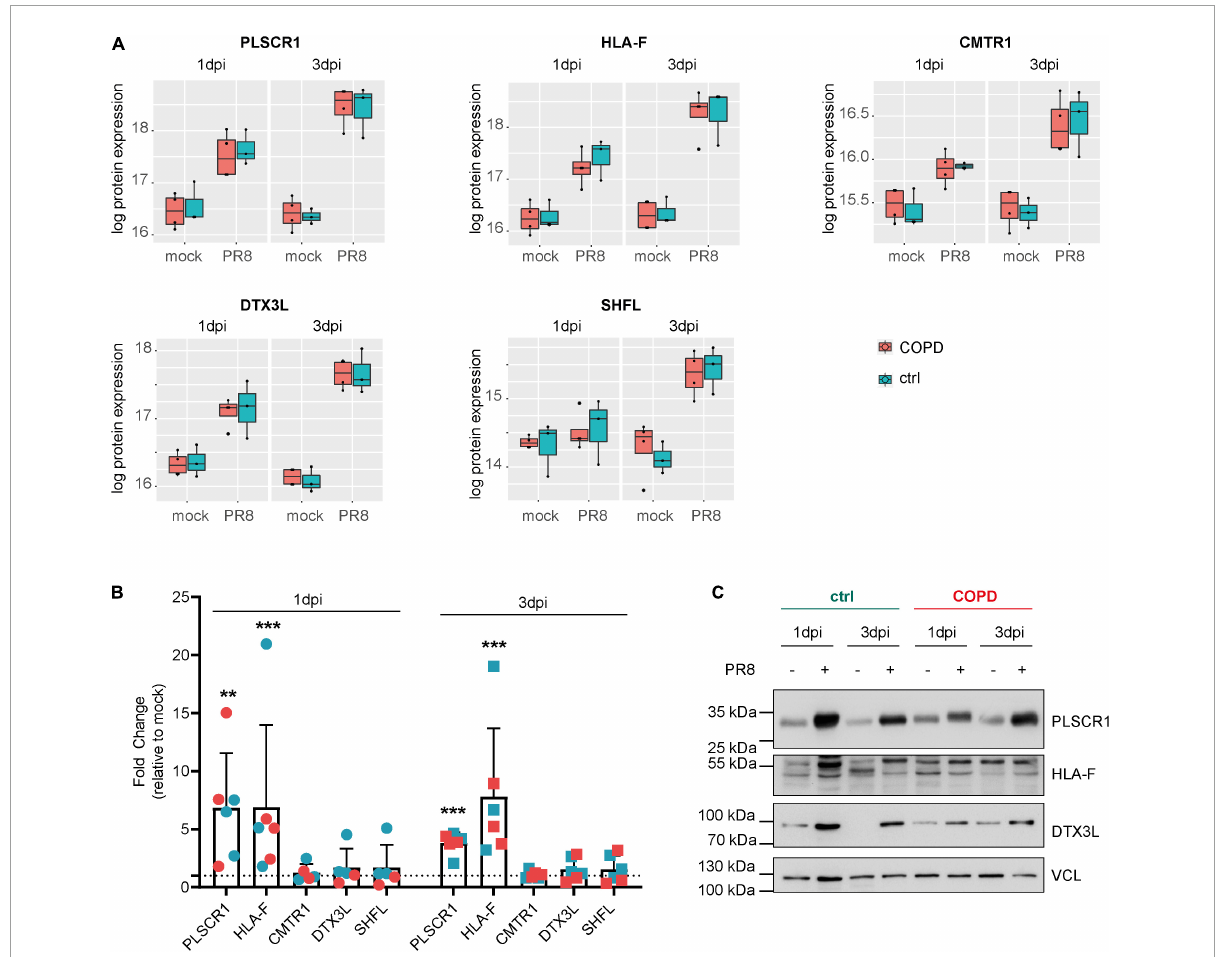
FIGURE5 Novel proteins upregulated in fully differentiated primary human bronchial epithelial cells (phBECs) independent of disease state post-influenza virus infection. (A) Box plots of significantly upregulated novel proteins in fully differentiated phBECs on days 1 and 3 post-influenza virus infection (dpi). PLSCR1, phospholipid scramblase 1; HLA-F, human leukocyte antigen class I histocompatibility antigen, α chain F; CMTR1, cap-specific mRNA (nucleoside-2 (cid:48) - O -)-methyltransferase 1; DTX3L, E3 ubiquitin–protein ligase DTX3L; SHFL, shiftless antiviral inhibitor of ribosomal frameshifting protein. Box plots depict the median (middle horizontal line), the 25 and 75% percentile (lower and upper edge of the box), and the range between the largest and smallest value up to a maximum of 1.5 × interquartile range (vertical lines). Data points beyond that range are regarded as outliers and are shown as individual points. (B) mRNA expression of novel genes 1 and 3 dpi (PR8/mock). For some COPD phBECs samples, the obtained amount of RNA was insufficient to cover all qPCR reactions, restricting the COPD-derived samples to n = 3 and n = 2 on 1 dpi. Symbol legend (in analogy to panels A and C): Cyan squares, ctrl samples; red squares, COPD samples. (C) Western blots of PLSCR1, HLA-F, and DTX3L. VCL (vinculin) was used as a loading control. Irrelevant parts of the Western blot images were cropped to only present the areas of interest. Uncropped Western blot images are given in Supplementary Figure 9